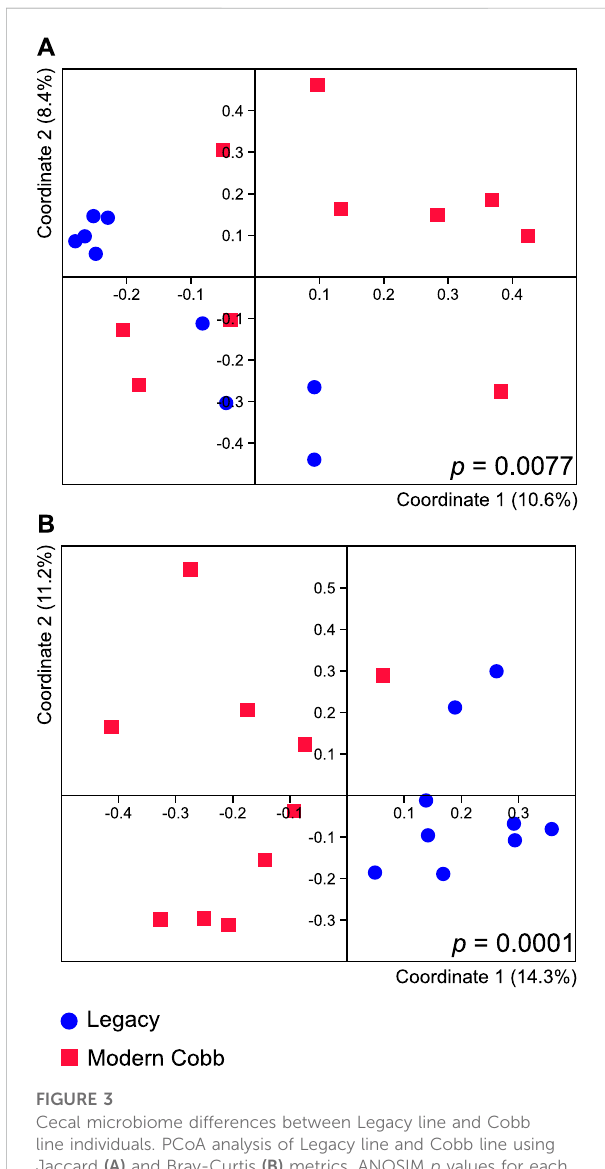
FIGURE 3 Cecal microbiome differences between Legacy line and Cobb line individuals. PCoA analysis of Legacy line and Cobb line using Jaccard (A) and Bray-Curtis (B) metrics. ANOSIM p values for each metric are indicated in the fi gure. Legacy n = 9, Cobb n =